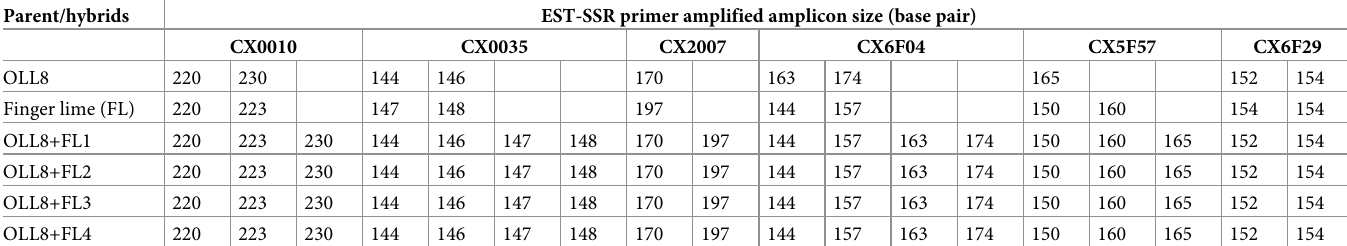
Table 2. Use of expressed sequence tag–simple sequence repeat (EST-SSR) to detect alleles and confirm allotetraploid somatic hybrids between OLL8 sweet orange and the finger lime ( C . australasica) .